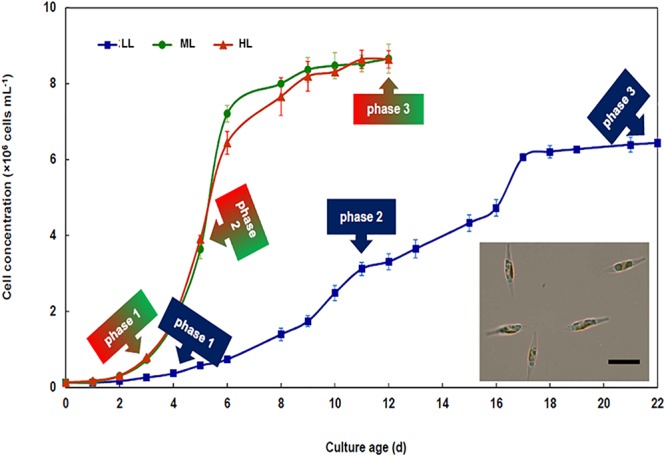
Growth of Phaeodactylum tricornutum under different light intensities. Time course of cell density of cultures developing under 30 (LL), 300 (ML), and 1000 (HL) μmol photons PAR m-2 s-1. Each curve presents typical growth phases, i.e., lag (phase 1), exponential (phase 2), and plateau (phase 3). The sampling time in each phase is indicated using arrows. The insert presents a light microscopy picture of Phaeodactylum tricornutum grown under ML. The bar indicates 10 μm. Mean values obtained from three biological replicates and SD are presented.